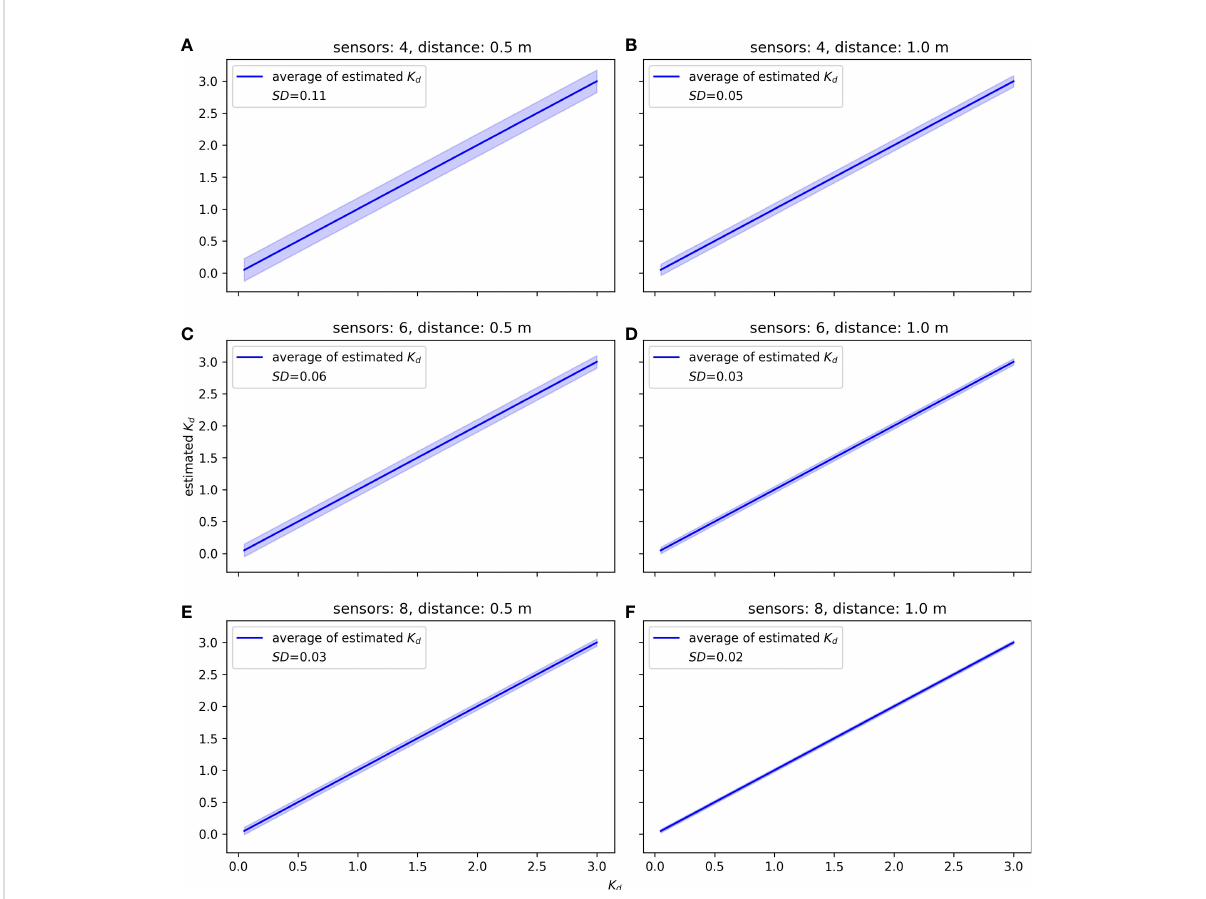
FIGURE 6 (A) Estimation of the error of the K d measured with 4 modules of the KduPRO separated by 0.5 m of distance. (B) Estimation of the error of the K d measured with 4 modules of the KduPRO separated by 1.0 m of distance. (C) Estimation of the error of the K d measured with 6 modules of the KduPRO separated by 0.5 m of distance. (D) Estimation of the error of the K d measured with 6 modules of the KduPRO separated by 1.0 m of distance. (E) Estimation of the error of the K d measured with 8 modules of the KduPRO separated by 0.5 m of distance. (F) Estimation of the error of the K d measured with 8 modules of the KduPRO separated by 1.0 m of distance. All the plots shows the average of the estimated K d (solid blue line) and the 90% con fi dence interval (the shadowed sky blue